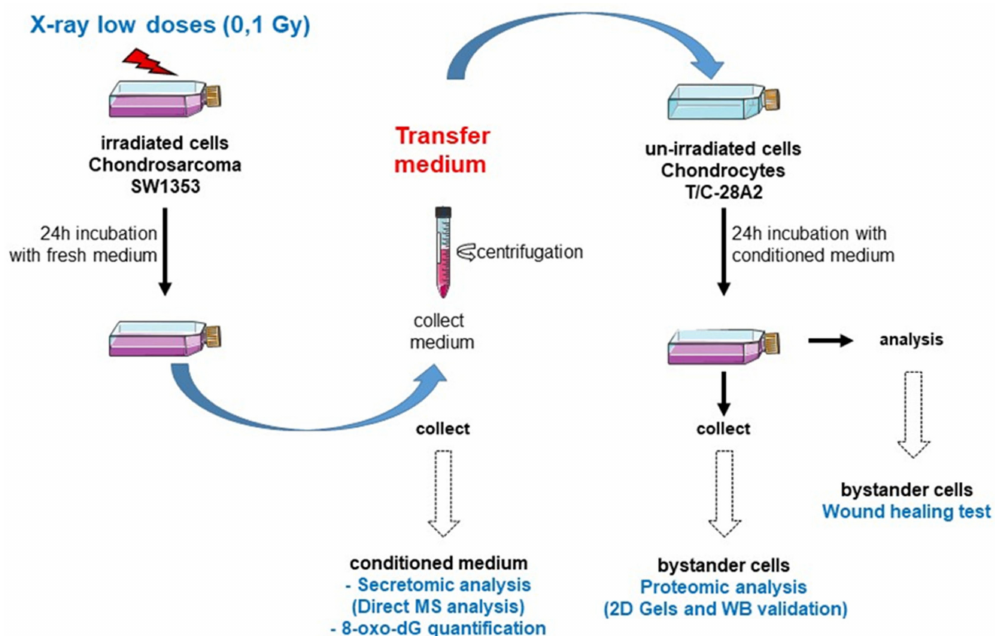
Figure 7. Schematic representation of experiments followed for the medium transfer protocols. Chondrosarcoma cells (SW1353 cell line) were irradiated at confluence in T25 flasks with X-rays or sham irradiated. Immediately after irradiation, the medium was changed with fresh new medium and incubated for 24 h. Then, the conditioned medium was centrifuged and collected. This conditioned medium (three independent biological replicates) was then analyzed for proteomic composition (secretomic analysis by direct MS analysis) or 8-oxo-dG quantification; or transferred to non-irradiated chondrocytes (T/C-28A2 cell line) for 24 h in T25 flasks with the same cell density. Then, cells were collected for proteomic composition (2D gel comparison and WB validation) or woundhealing